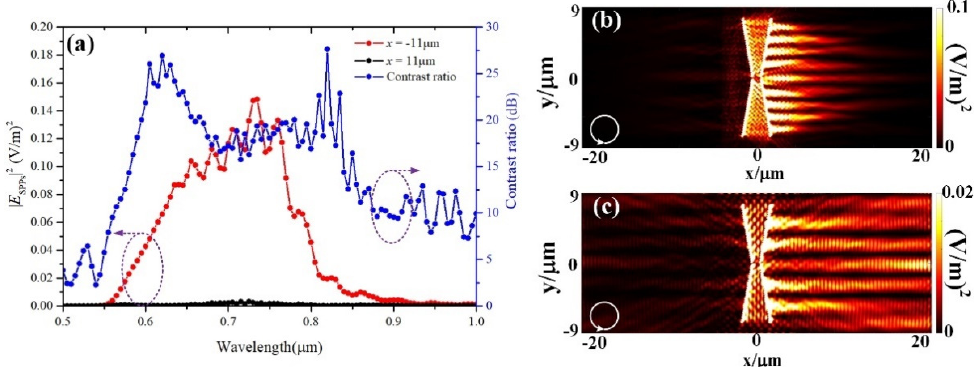
Figure 8. ( a ) The SPP intensity contrast ratio between the points ( − 11 µm, 0) and (11 µm, 0) under LCP incident light in the wavelength range of 500 to 1000 nm. ( b ) The SPP intensity distribution on the metal/air interface under LCP incident light when the wavelength is 565 nm. ( c ) The SPP intensity distribution on the metal/air interface under LCP incident light when the wavelength is 875 nm.